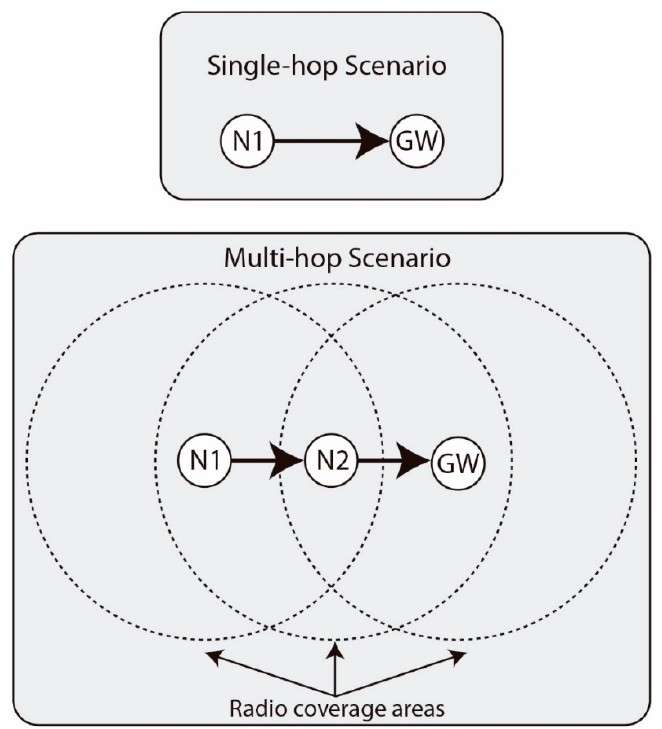
Figure 4. Single-hop and multi-hop scenarios implemented in our tests.